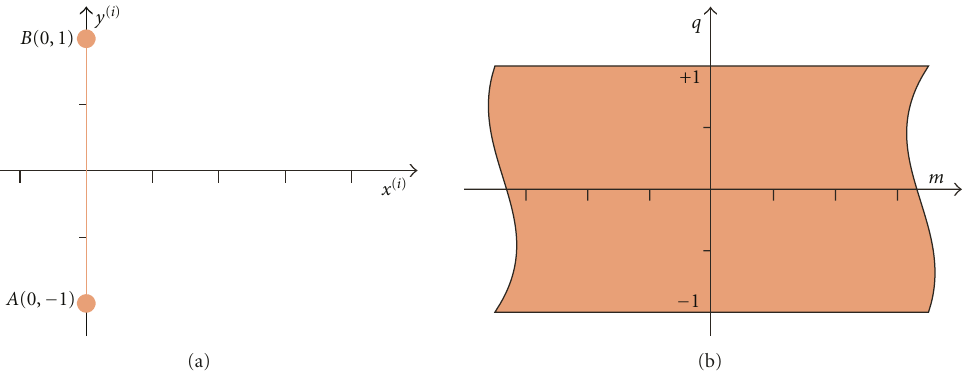
Figure 1: The specialized RRP (a) and the set of rays passing through the reference reflector in the ( m , q ) domain (visibility region from the reference reflector)